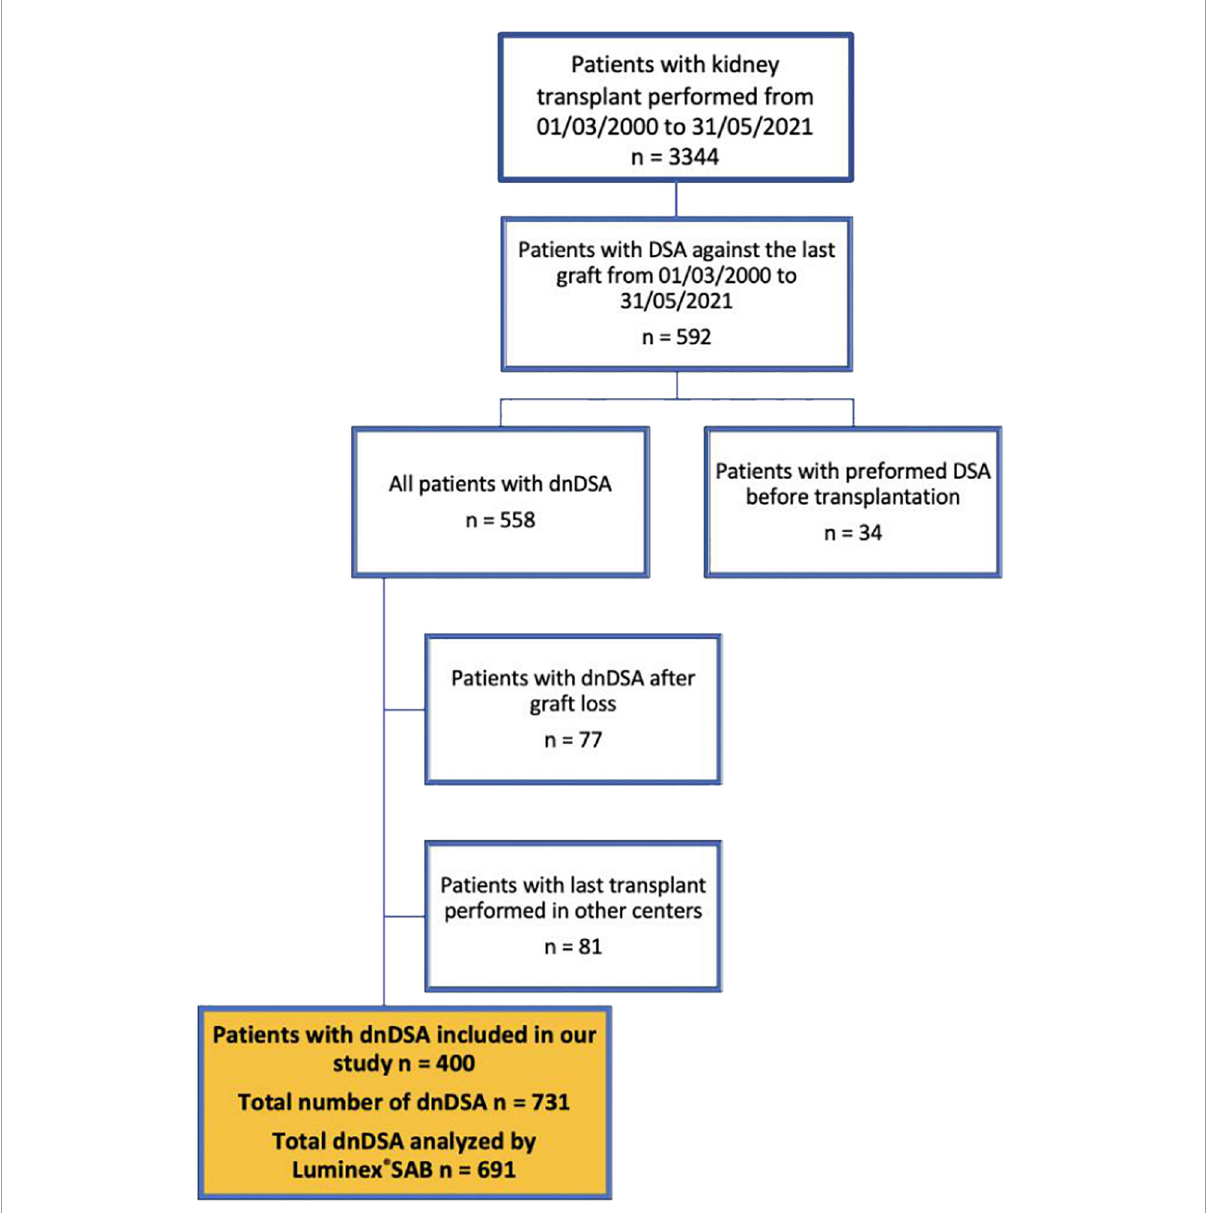
FIGURE1 Flowchart of the patients in our study. DSA, donor-specific antibodies; dnDSA, de novo donor-specific antibodies; SAB, single antigen